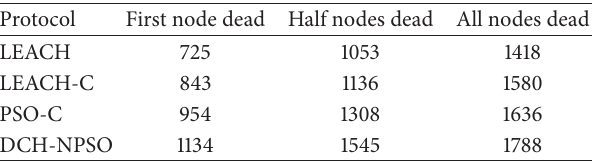
Table 2: Network lifespan comparison.